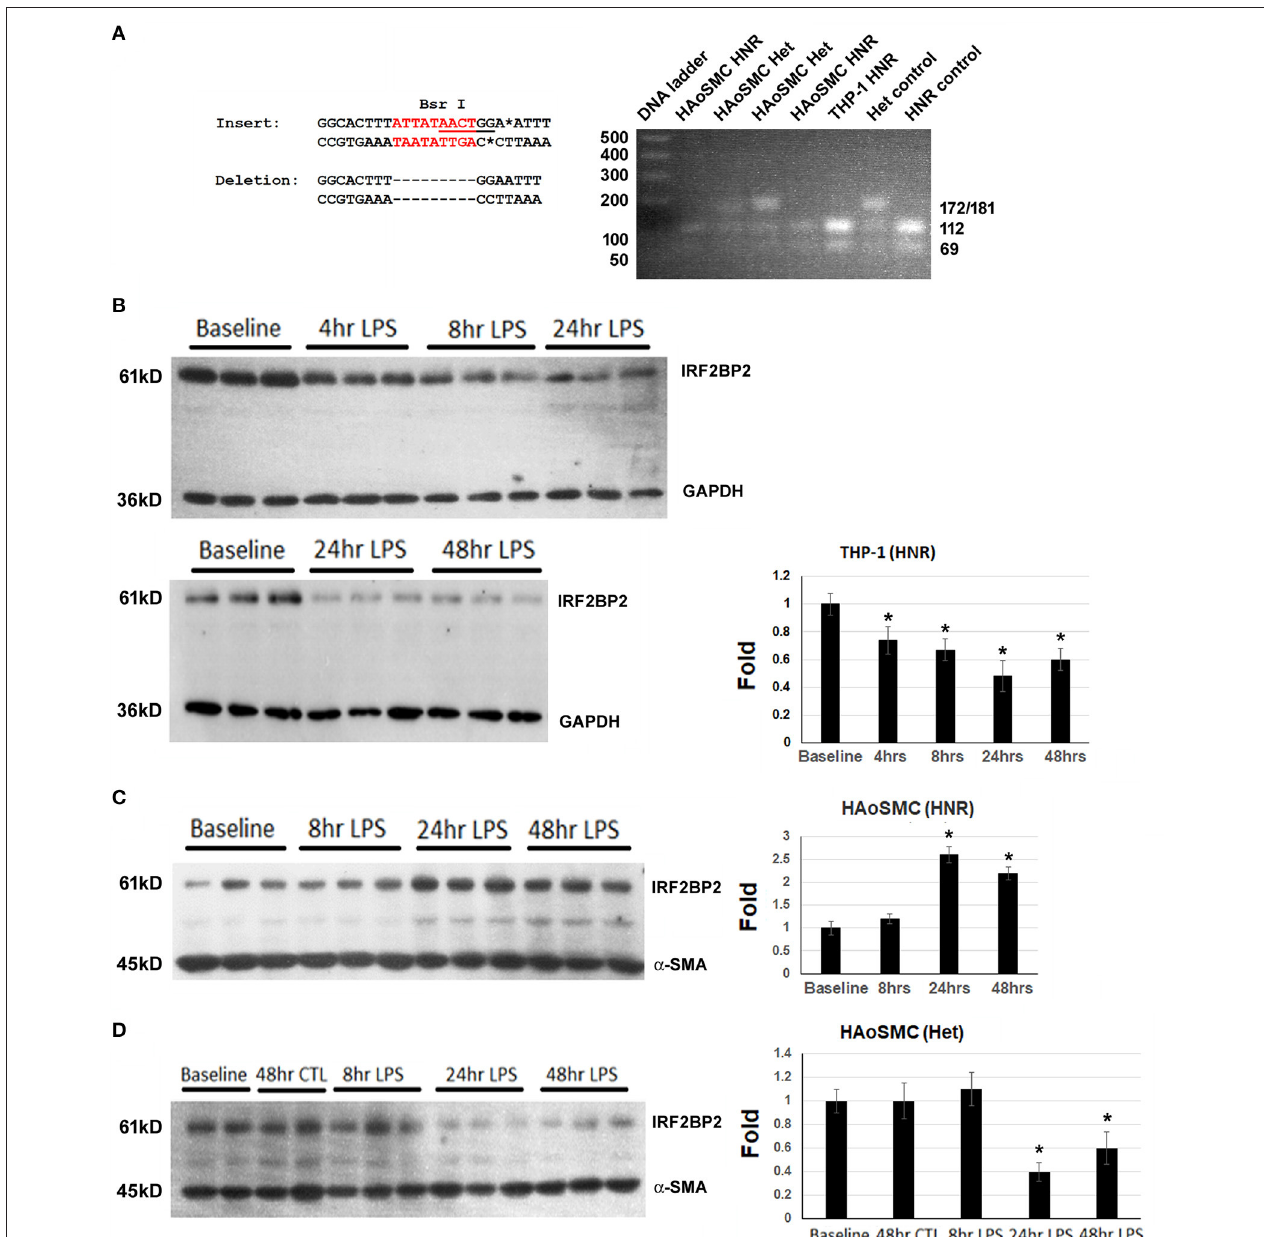
FIGURE 1 | Cell type-specific and allele-specific regulation of IRF2BP2 in response to innate immune activation. (A) BsrI restriction fragment length polymorphism (RFLP) genotyping of genomic DNA from THP-1 cells and Human aortic smooth muscle cells (HAoSMC). The insertion sequence contains the BsrI site, while the deletion allele does not. HNR, homozygous non-risk; Het, heterozygous. (B) Human THP-1 macrophage cells homozygous for the non-risk allele (HNR, non-deletion allele of rs3045215) down-regulate IRF2BP2 protein in response to LPS. (C) Human aortic smooth muscle cells (HAoSMC) from HNR donors upregulate IRF2BP2 in response to LPS ( n = 3 donors). (D) HAoSMC from heterozygote donors down-regulate IRF2BP2 protein levels in response to LPS ( n = 2 donors). Representative blots are shown. Bands were quantified by densitometry and normalized to GAPDH for THP-1 blots and alpha smooth muscle actin for HAoSMC blots. Values are fold change relative to average of baseline values. Cells were treated with 10ng/ml LPS. * p < 0.05 from baseline by Student’s t -test. Moreover, the effect of LPS on RBP binding to IRF2BP2 mRNA is lost with the deletion (risk)